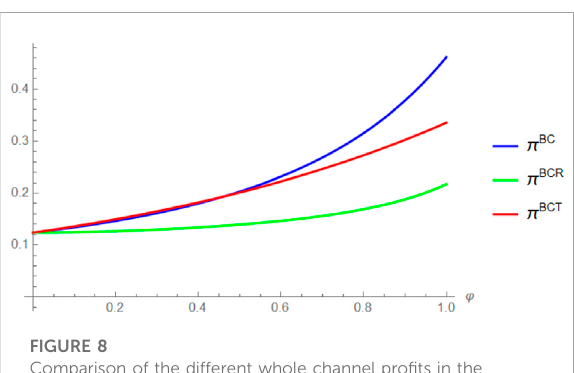
FIGURE 8 Comparison of the different whole channel pro fi ts in the scenario with adopting blockchain